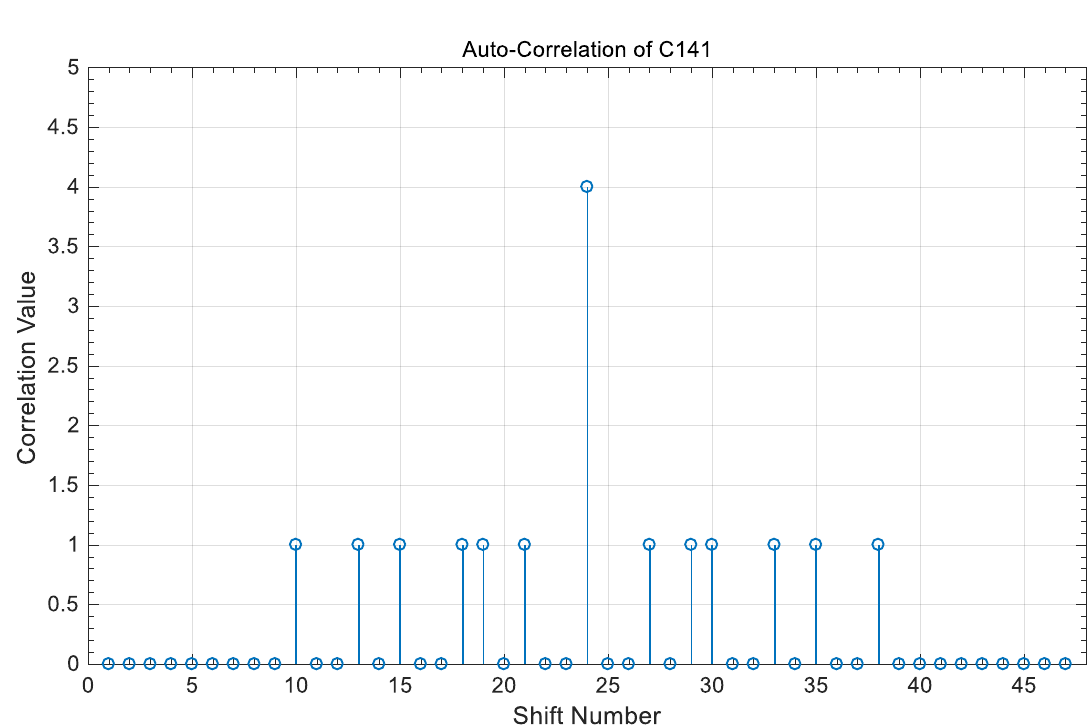
Figure 5. Auto-correlation of 𝐶 141 sequence, 𝑃 1 = 5 and 𝑃 2 = 7.